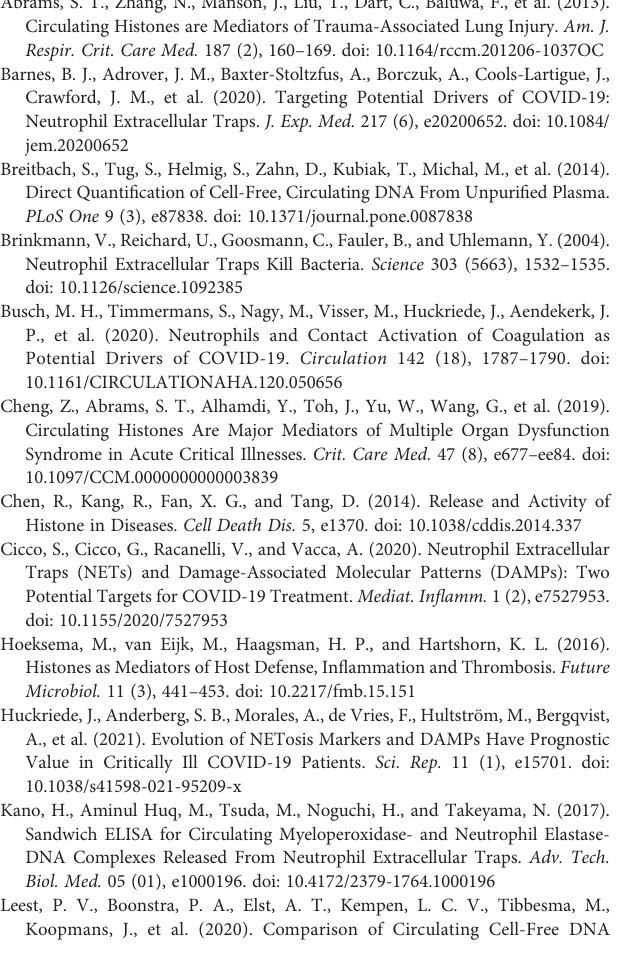
Supplementary Figure 1 | Overview of histone H3 western blot detection method. On the left western blot, the molecular weight marker is followed by the histoneH3standard,withamolecularweightaround15kDa,followedby10patient samples. Sample 3 – 6 are examples of negative histone H3 samples, samples 2 and 7 are examples of positive uncleaved H3 samples with one band at 15 kDa. On the right western blot, the protein standard is followed by 10 patient samples. In this